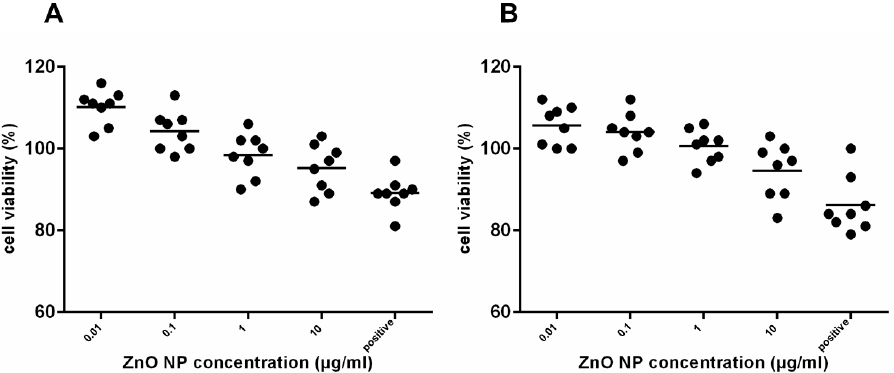
Figure 3. Viability of human mesenchymal stem cells (hMSC) after ( A ) osteogenic and ( B ) adipogenic differentiation for 1 week and exposure to ZnO-NP. Sample size n = 8. The untreated control was defined as 100%. A quantity of 200 μ M tert-butylhydroperoxide (t-BHO) served as positive control. The dots show the single values of viable cells as well as the median. No significant decrease of hMSC viability (%) was observed after exposure to ZnO-NP concentrations of 0.01, 0.1, 1, and 10 μ g/mL. For statistical analysis, the Wilcoxon Test was performed. Statistical significance compared with the control based on a p -value <